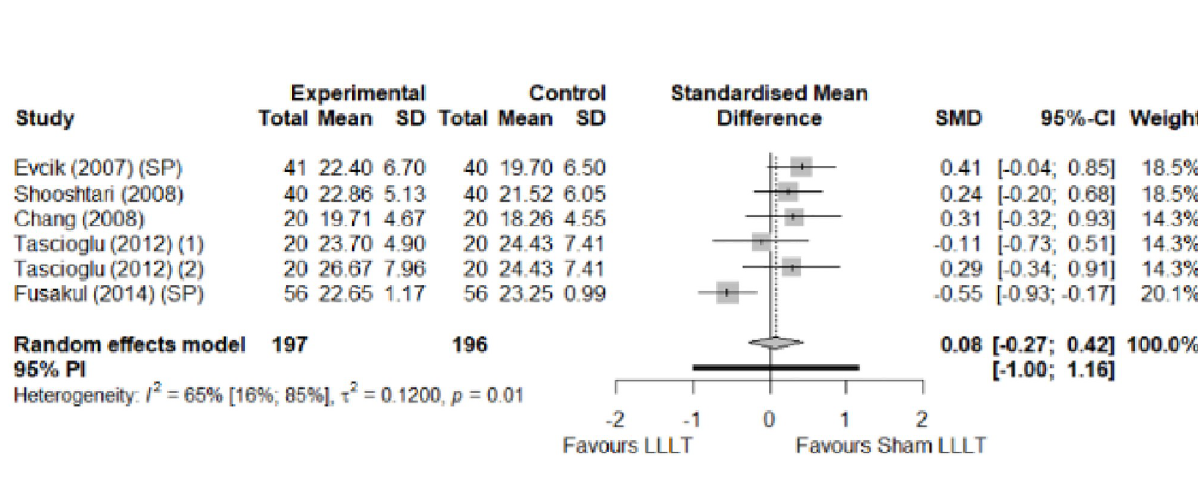
PLOS ONE | https://doi.org/10.1371/journal.pone.0248484 March 18, 2021 10 /